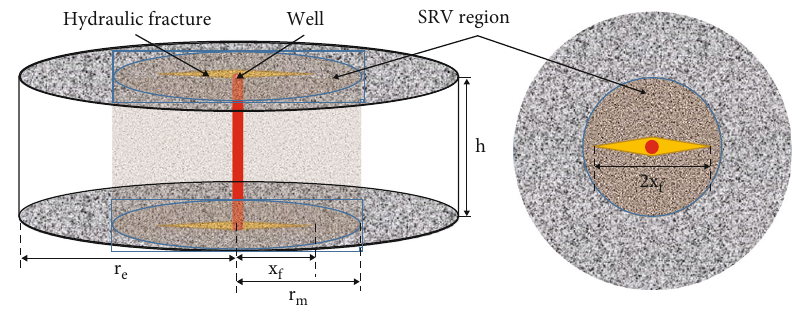
Figure 1: Reservoir model with SRV.